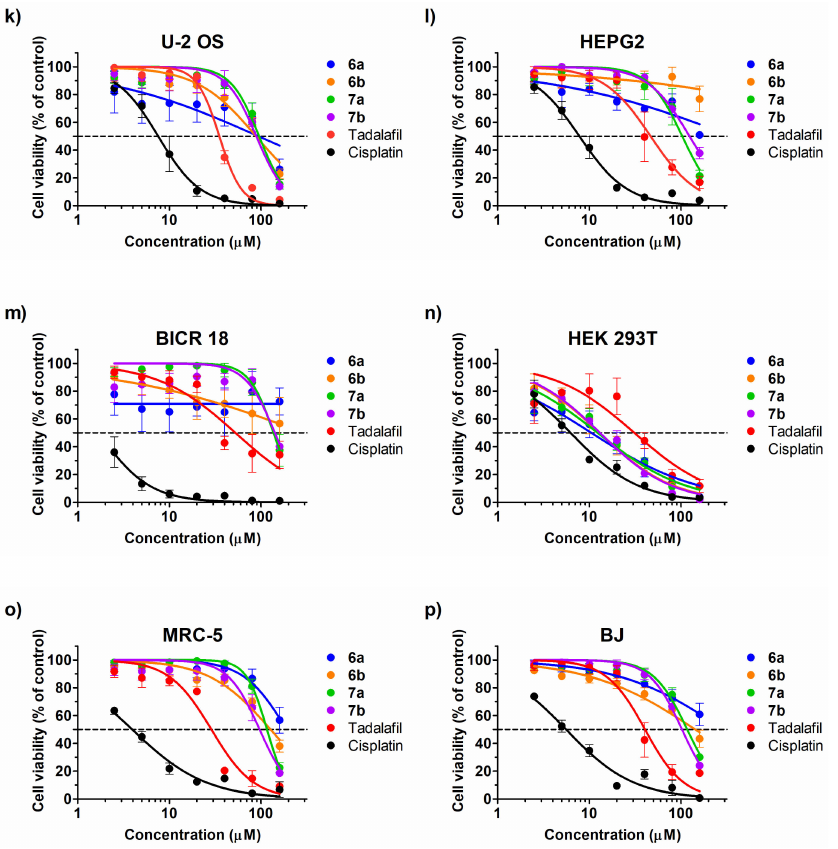
Figure 11. Viability of selected human cell lines in response to tadalafil and its analogues 6a,b , 7a,b , and cisplatin evaluated with MTT metabolism assay. A-431 ( a ), A549 ( b ), HCT116 ( c ), HCT116p53 − / − ( d ), U-87 MG ( e ), U-251 MG ( f ), MCF7 ( g ), MDA-MB-231 ( h ), SKG-IIIa ( i ), HeLa ( j ), U-2 OS ( k ), HEPG2 ( l ), BICR 18 ( m ), HEK 293T ( n ), MRC-5 ( o ) and BJ ( p ). Cells were incubated with increasing concentrations (range = 1.25–160 µ M) of tadalafil, compounds 6a,b , 7a,b , and cisplatin for 72 h. Percentage of cell viability inhibition was calculated in comparison to cells treated with DMSO only (regarded as a control). Each point of curves represents the mean ± SD of at least three independent experiments done in triplicate. Nonlinear fit of the dose-log response curves was done in GraphPad Prism 5.03. Table 1. Calculated IC 50 values of tadalafil and its analogues 6a,b , 7a,b , and cisplatin on selected human cell lines. Comp.